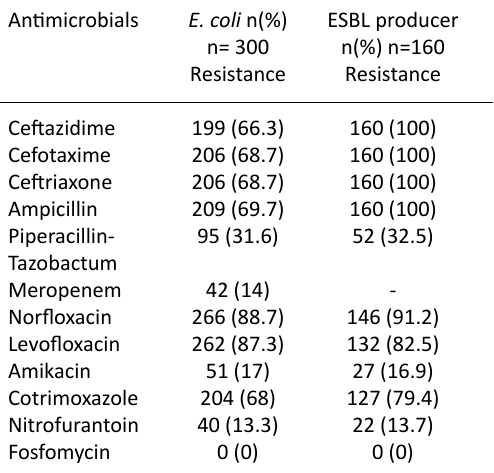
Table 6. Antibiotic resistance pattern in UTI by E. coli n=300 and in ESBL producer